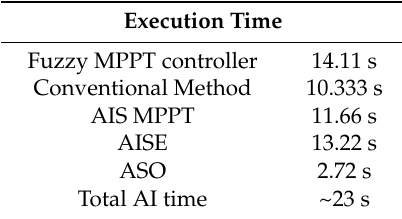
Figure 14. The DFIG rotor speed for both conventional and AI Eco-MPPT strategies. Table 2. MATLAB execution time for different